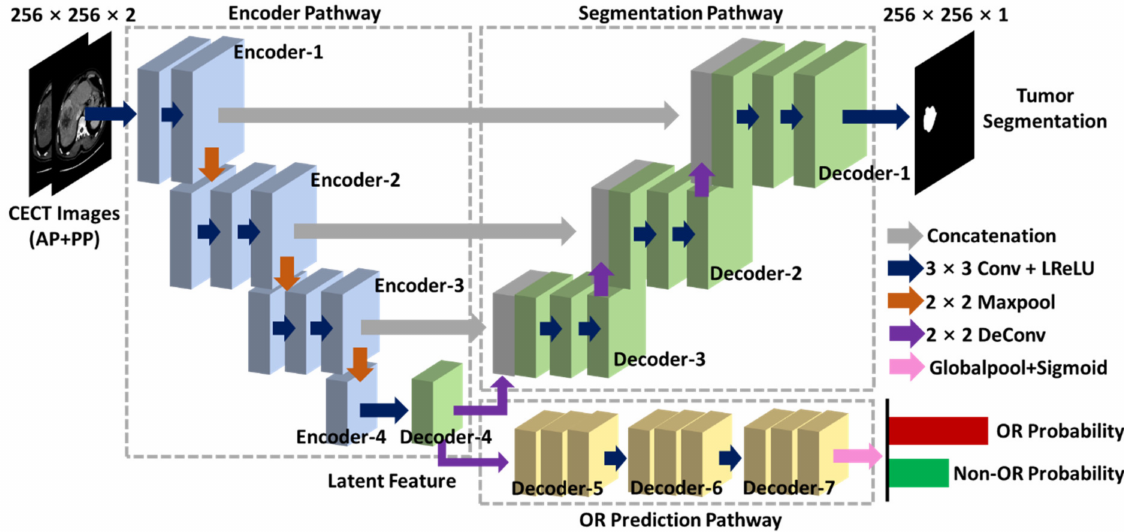
Figure 2. The structure of the proposed multi-DL (multi-task deep learning)